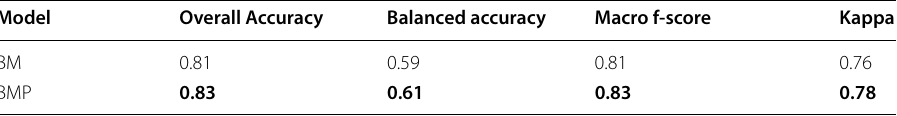
Highest performing values are highlighted in